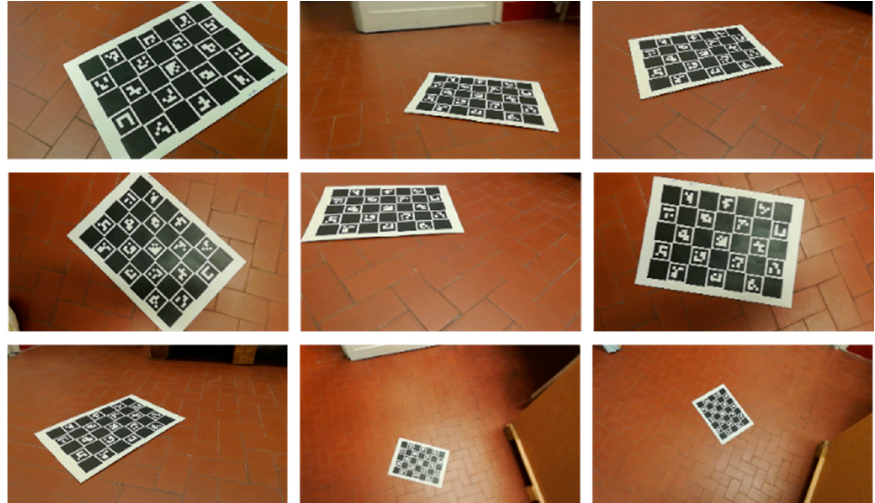
Figure 2. Camera calibration process. The camera takes several pictures of the calibration board from different perspectives. By Post-processing all these images, it is possible to get the camera calibration parameters.